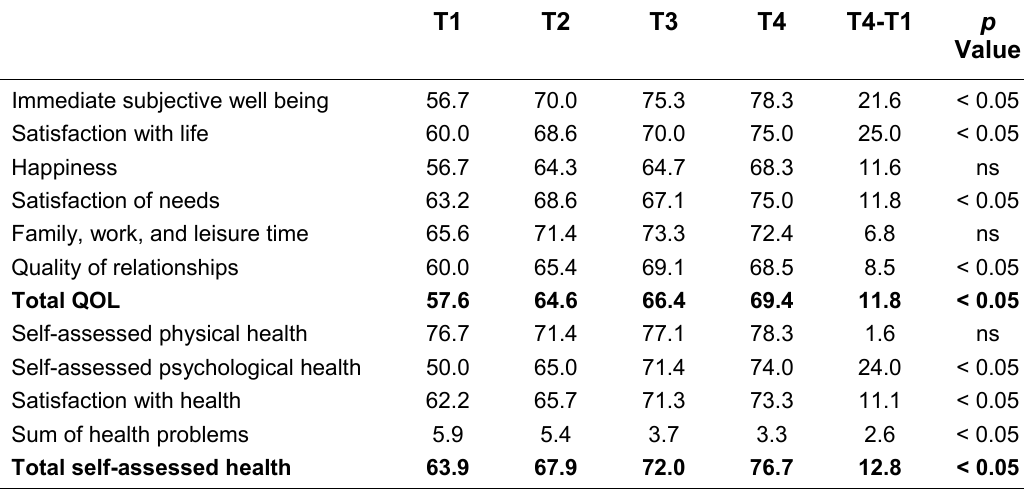
Measurings of Global QOL and Self-Assessed Health with the SEQOL Questionnaire, Before and After the 5-Day QOL Intervention